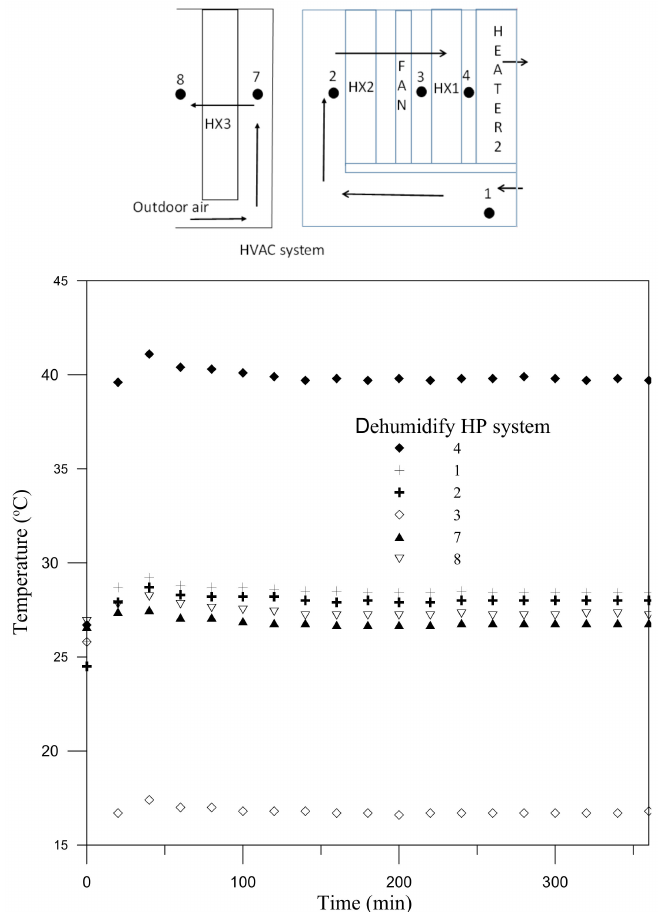
Figure 6. Temperature distribution in DHP